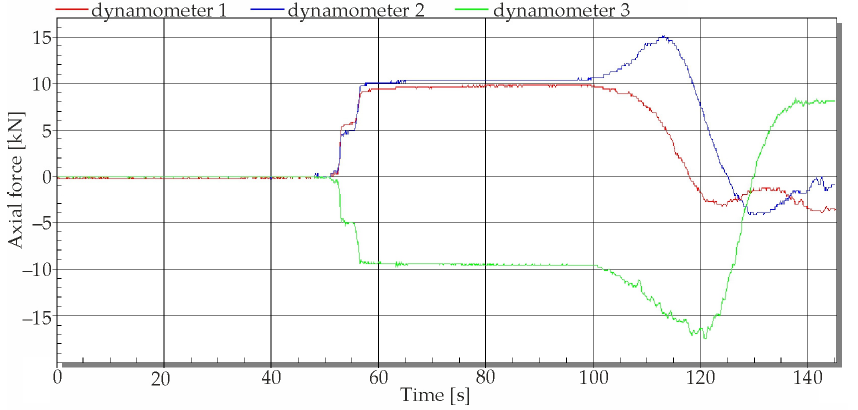
Figure 10. The time courses of axial forces in Bolts No. 8, No. 19, and No. 24 when loading the empty ladle into Basket 1 and rotating the pedestal to the casting position.